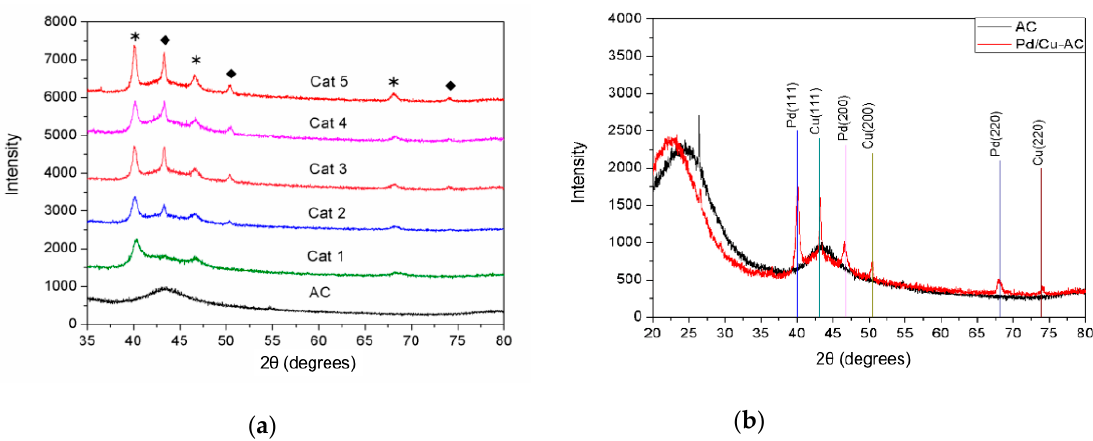
Figure 1. ( a ) XRD patterns of activated carbon (AC) and Pd/Cu@AC catalysts prepared using different